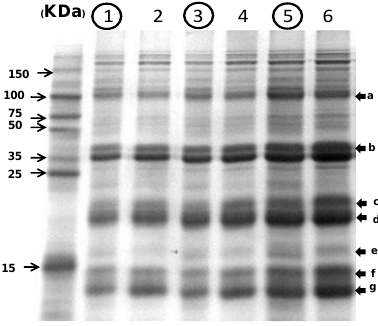
Figure 9. SDS-PAGE analysis of residual proteins extracted from hydrolyzed whole and chalky brown rice flour. 1, hydrolyzed chalky brown rice (Koshihikari) at 37 °C for 16 h; 2, hydrolyzed whole brown rice (Koshihikari) at 37 °C for 16 h; 3, hydrolyzed chalky brown rice (Koshihikari) at 37 °C for 6 h; 4, hydrolyzed whole brown rice (Koshihikari) at 37 °C for 6 h; 5, hydrolyzed chalky brown rice (Koshihikari) at 37 °C for 1 h; and 6, hydrolyzed whole brown rice (Koshihikari) at 37 °C for 1 h. Chalky brown rice grains are expressed in circled numbers; a, gluterin precursor; b, glutelin α -subunit; c, α -globulin; d, glutelin β -subunit; e – g, prolamin.